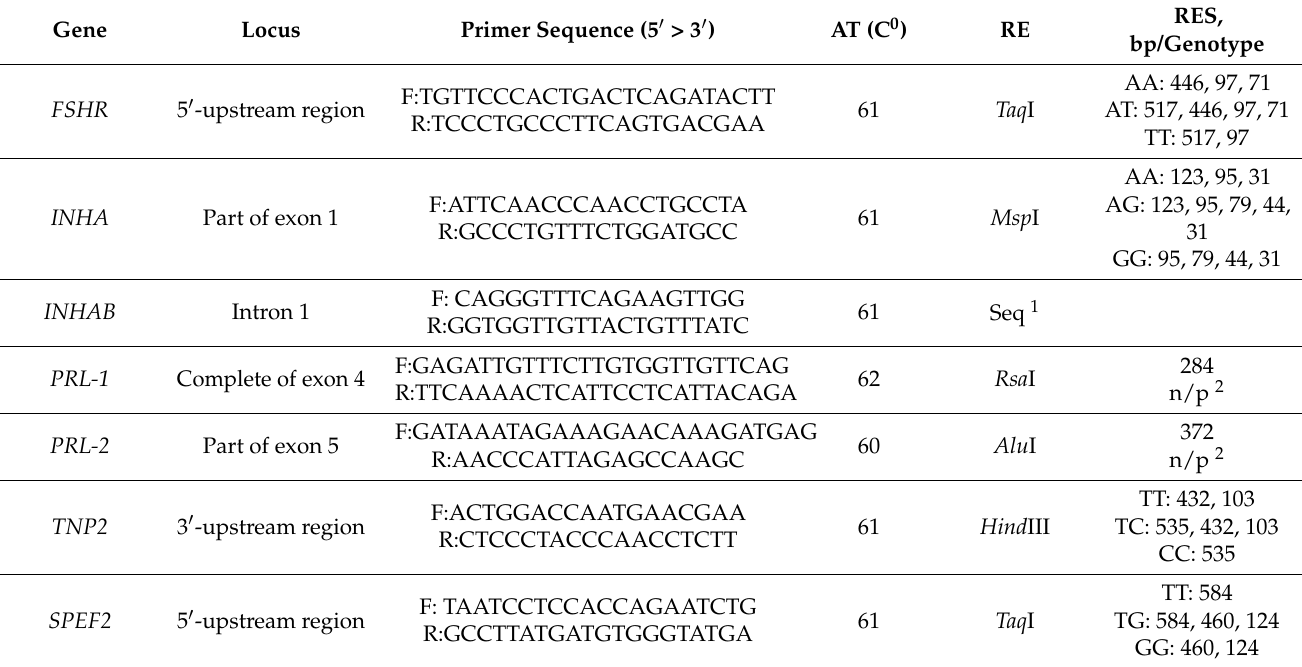
Table 1. The list of primers used in FSHR , INHA , INHAB , PRL (Sang et al., 2011), TNP2 (Gao et al., 2014) and SPEF2 (Guo et al., 2014)